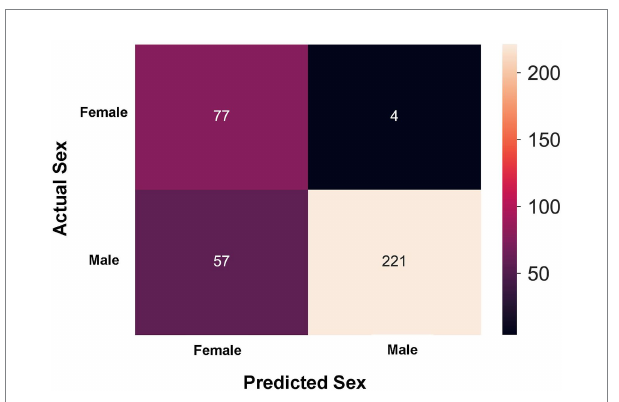
FIGURE 2 Sex prediction in patients with acute exacerbation chronic obstructive pulmonary disease (AECOPD) by the k-prototype algorithm.